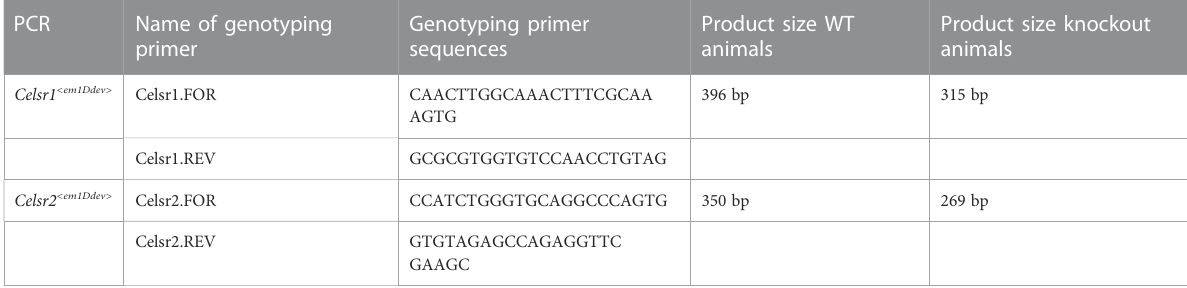
TABLE 1 Product information of key antibodies and reagents used in this study.